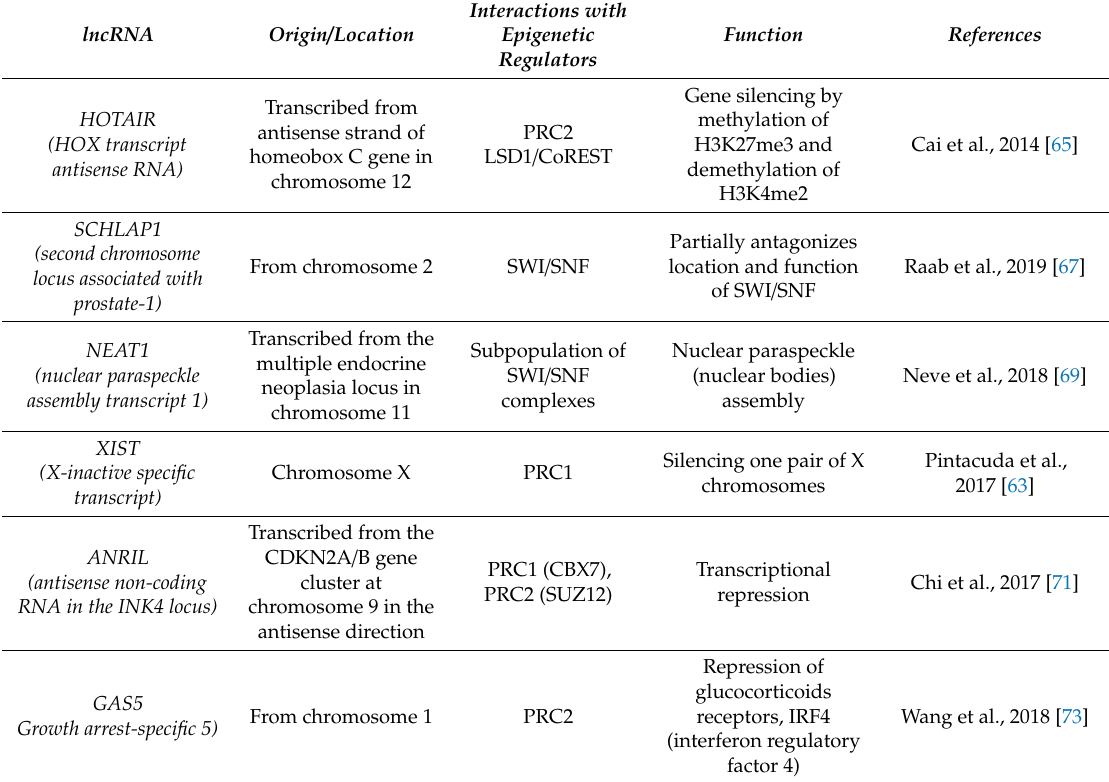
Table 2. Long non-coding RNA (LncRNA) interactions with epigenetic regulatory